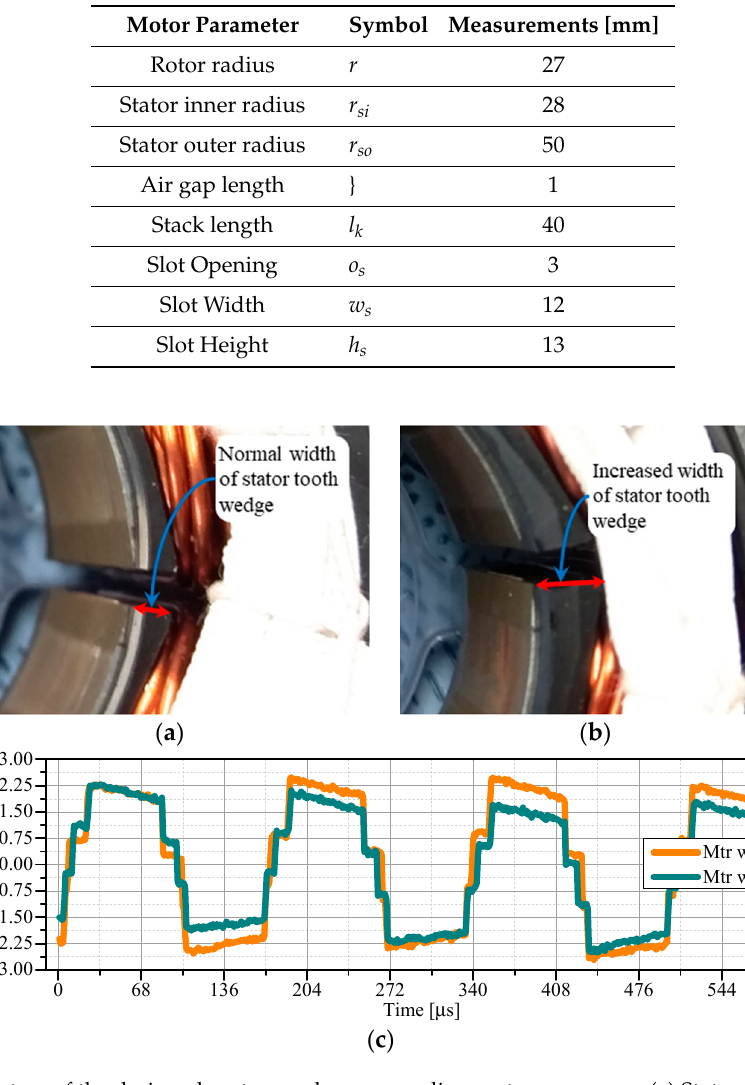
Figure 7. Stators of the designed motors and corresponding motor responses. ( a ) Stator with a normal tooth wedge. ( b ) Stator with an increased tooth wedge. ( c ) Comparison of the shaft voltage of the two motors.